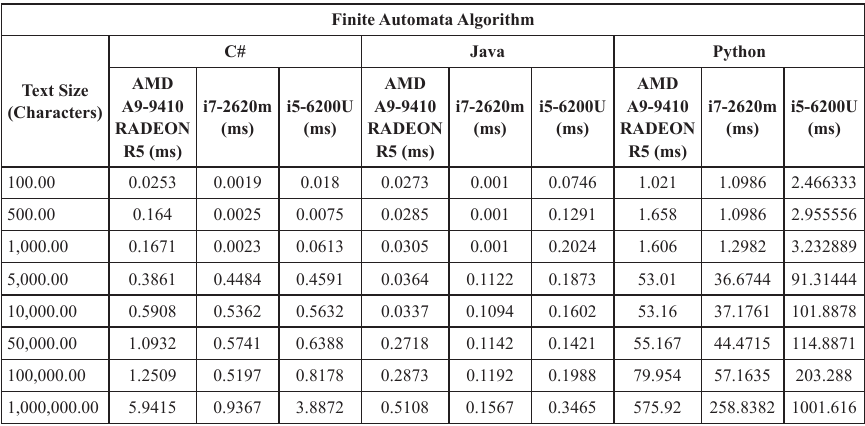
Table 4. Running time of Finite Automata algorithm in C#, Java and Python programming languages Finite Automata